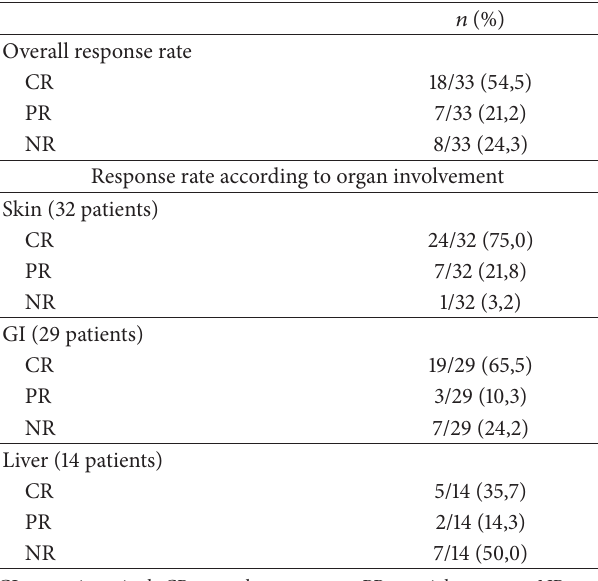
Table 3: Overall and organ specific response rate.